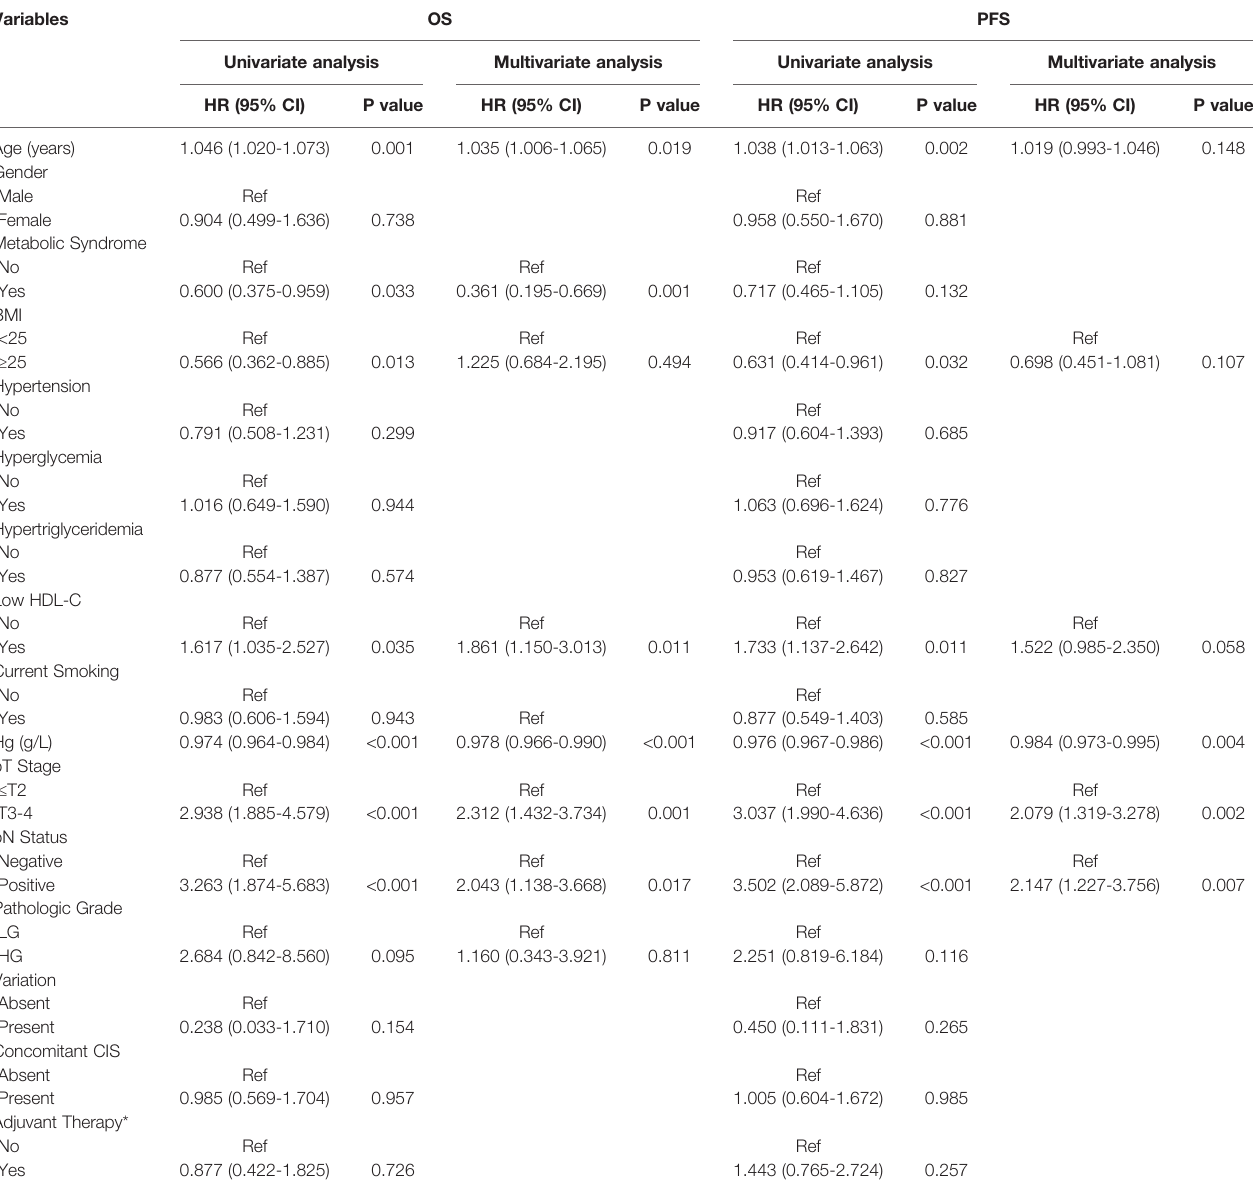
TABLE 3 | Univariate and multivariate analysis of prognostic factors using the Cox proportional hazards model for OS and PFS in propensity matched patients.